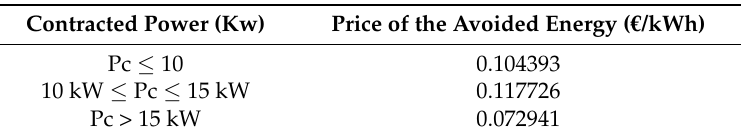
Table 4. Price of the avoided energy by power